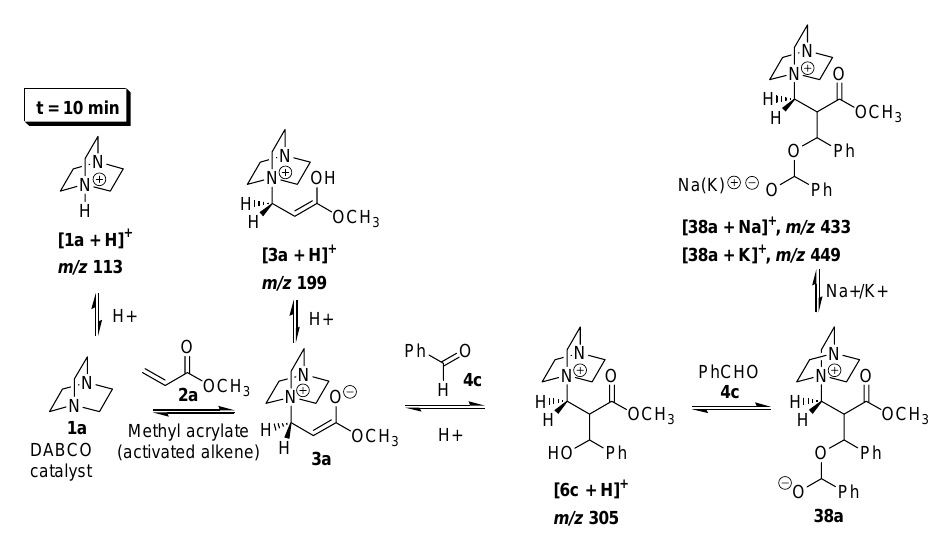
Figure 12. ESI(+) – MS of the MBH reaction solution co-catalyzed by a